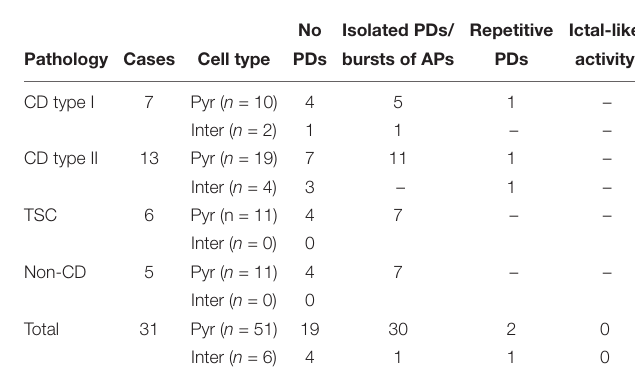
TABLE 2 | Effects of 4AP +